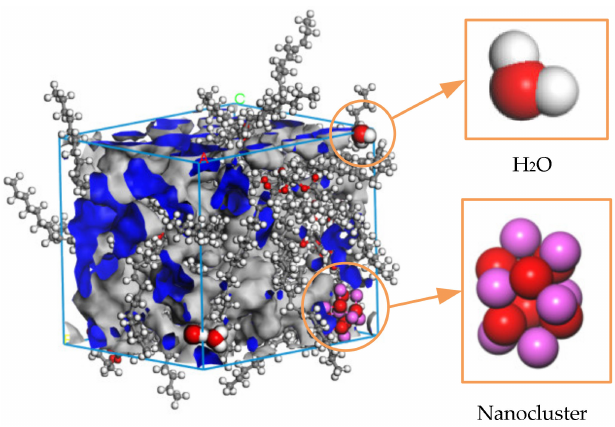
Figure 7. Free volume of the Al 2 O 3 nano-modified model at 343